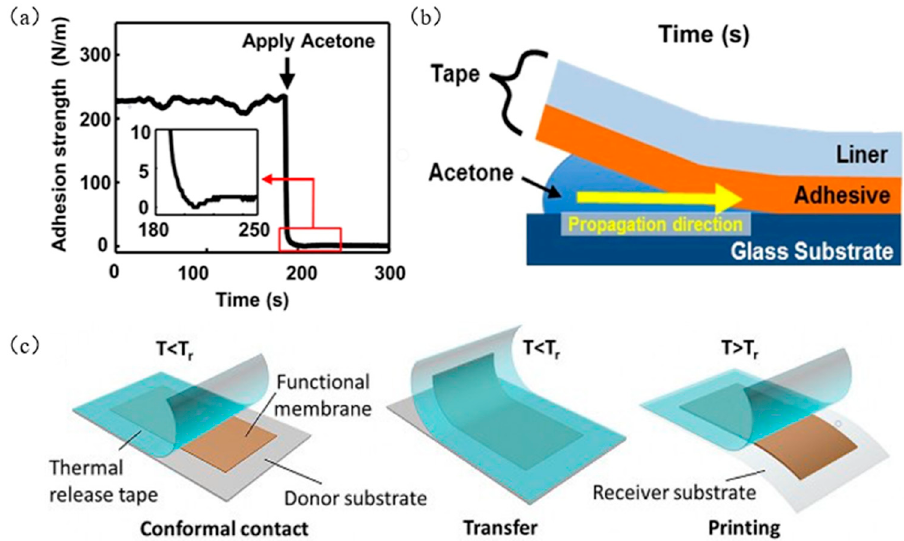
Figure 13. Tape-assisted transfer printing technology. ( a ) Change of 3M tape adhesion strength before and after adding acetone (reproduced from [75]), ( b ) schematic diagram of the competitive fracture of the tape interface (reproduced from [75]), and ( c ) heat release tape transfer printing diagram (reproduced from [76]).